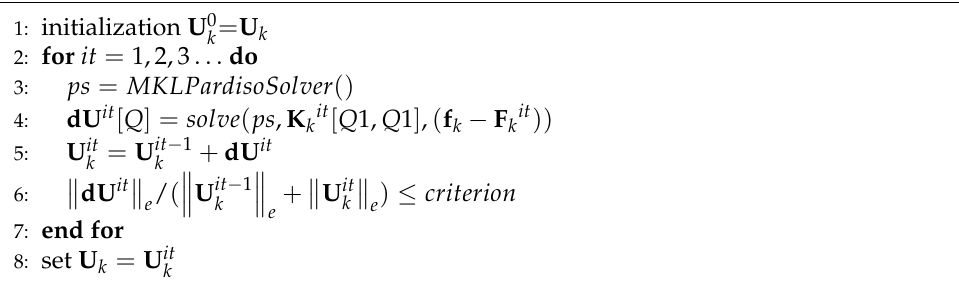
Algorithm 3 Newton iteration terminates